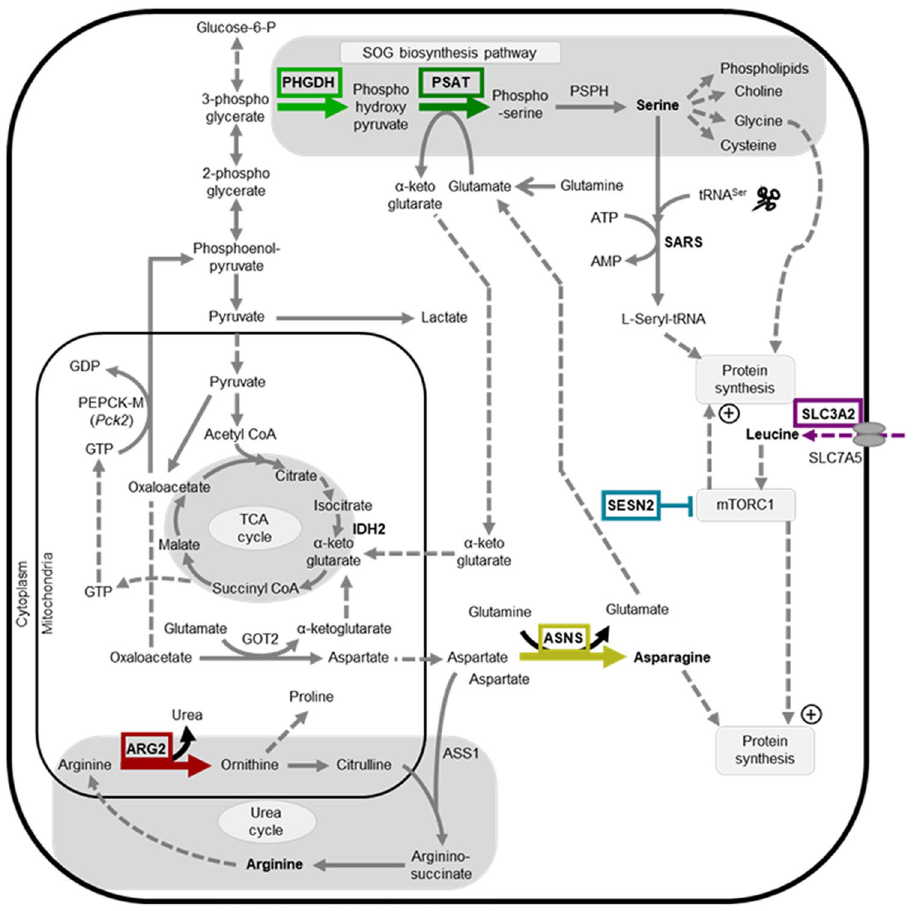
Figure 1. Schematic illustrating the role of AAV1-mediated targets associated with energy metabolism, protein synthesis and the urea cycle. Schematic highlights (in bold font with bold arrows) the different genes of interest (GOI) targeted for AAV1-mediated overexpression in this study and their function. GOI are involved in amino acid biosynthesis (Phosphoglycerate Dehydrogenase, PHGDH; Phosphoserine aminotransferase, PSAT1; Asparagine synthetase, ASNS), amino acid transport (Solute Carrier family 3 member 2, SLC3A2), the urea cycle (Arginase-2, ARG2) and an inhibitor of protein synthesis (Sestrin-2, SESN2). Relative mRNA expression was measured for GOIs, amino-acyl tRNA synthetase (Seryl-tRNA synthetase, SARS) and Isocitrate dehydrogenase-2 (IDH2) (highlighted in bold font